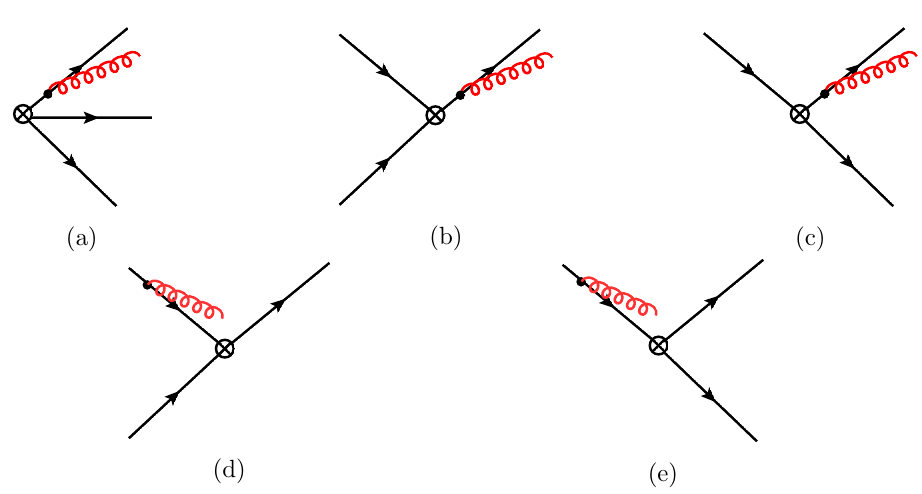
Figure 2. Kinematics of a tripole contribution to the soft factor in the collinear limit in di(cid:11)erent regions: (a) timelike splitting in A 0 , (b) timelike splitting in A 1 , A 2 , A 3 , (c) timelike splitting in A 4 , A 5 , A 6 , (d) spacelike splitting in A 1 , A 2 , A 3 , (e) spacelike splitting in A 4 , A 5 , A 6 . The curly gluon line represents the outgoing soft gluon with momentum q , while the lines with arrows are the tripole legs i; j; k . The arrow of time (cid:13)ows from left to right.